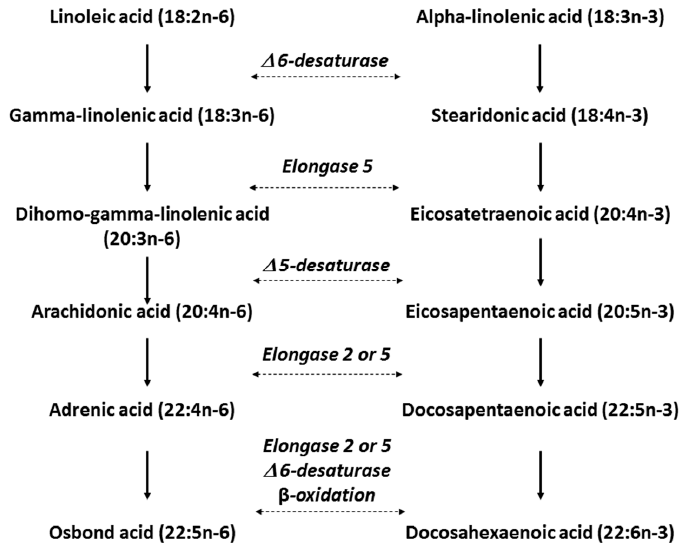
Figure 1. Pathway of metabolic interconversion of omega-6 and omega-3 polyunsaturated fatty acids. Abbreviation used: Δ , delta.